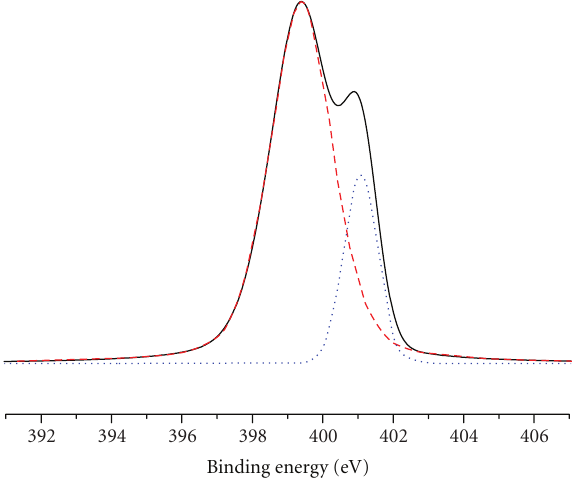
Figure 4: N1s XPS spectra for the RGO-Au nanocomposites.